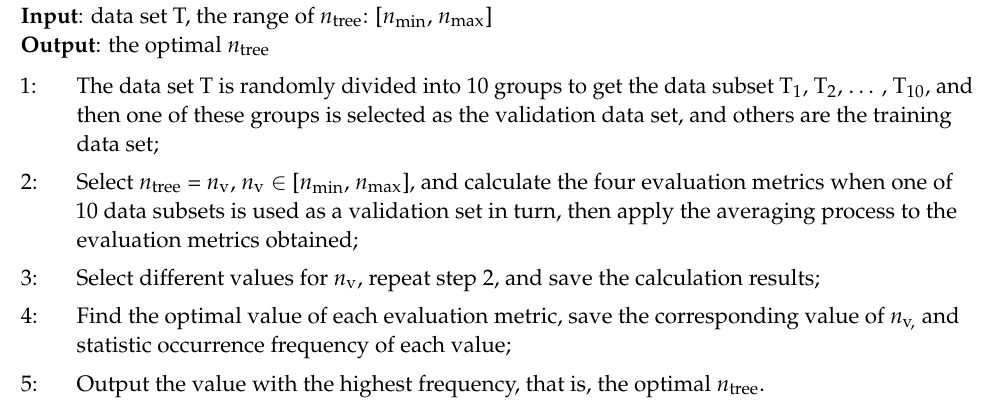
Algorithm 1: The algorithm of parameter